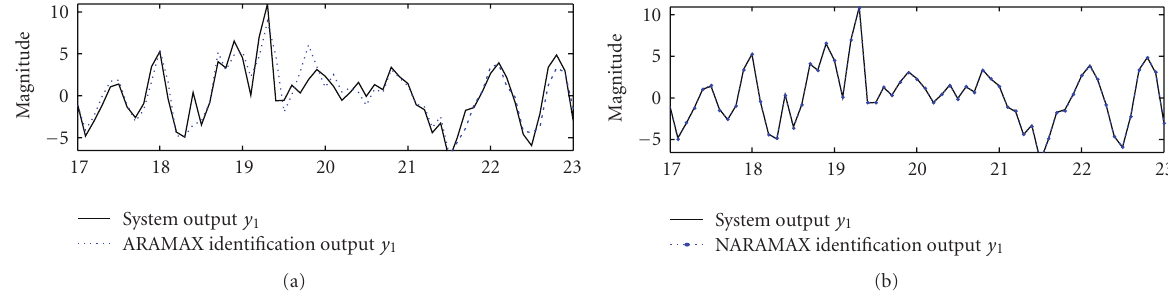
Figure 5: The trajectories of the output 1 for ARMAX and NARMAX models.